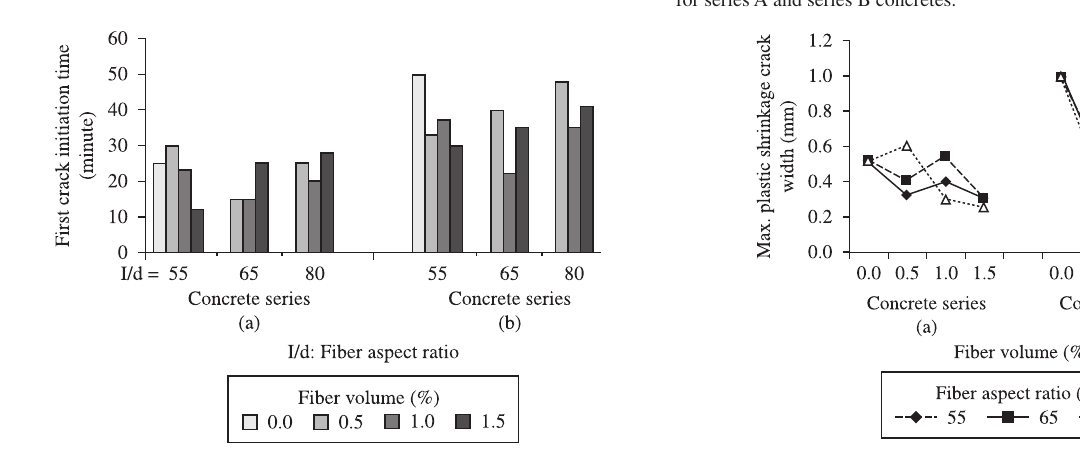
Figure 3. Effect of fiber volume and fiber aspect ratio on first crack initiation time for series A and series B concretes.